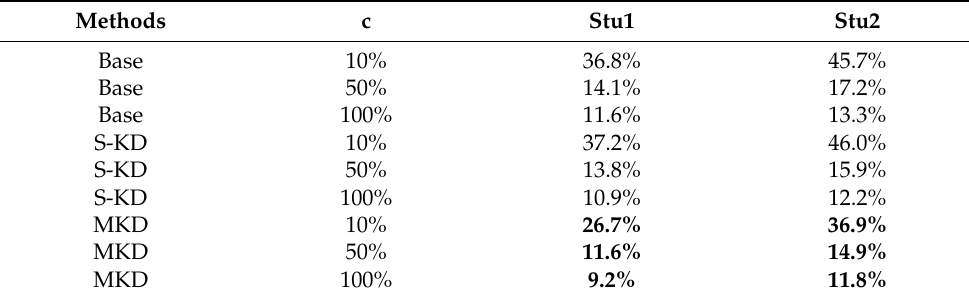
Table 7. The CER of MKD in different dataset